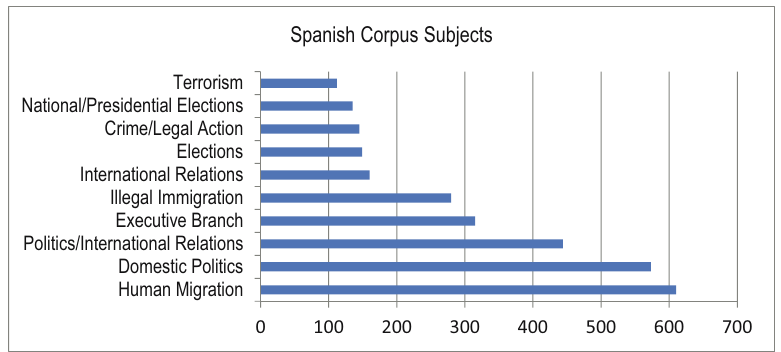
Figure 5: Most mentioned topics in the Spanish corpus.